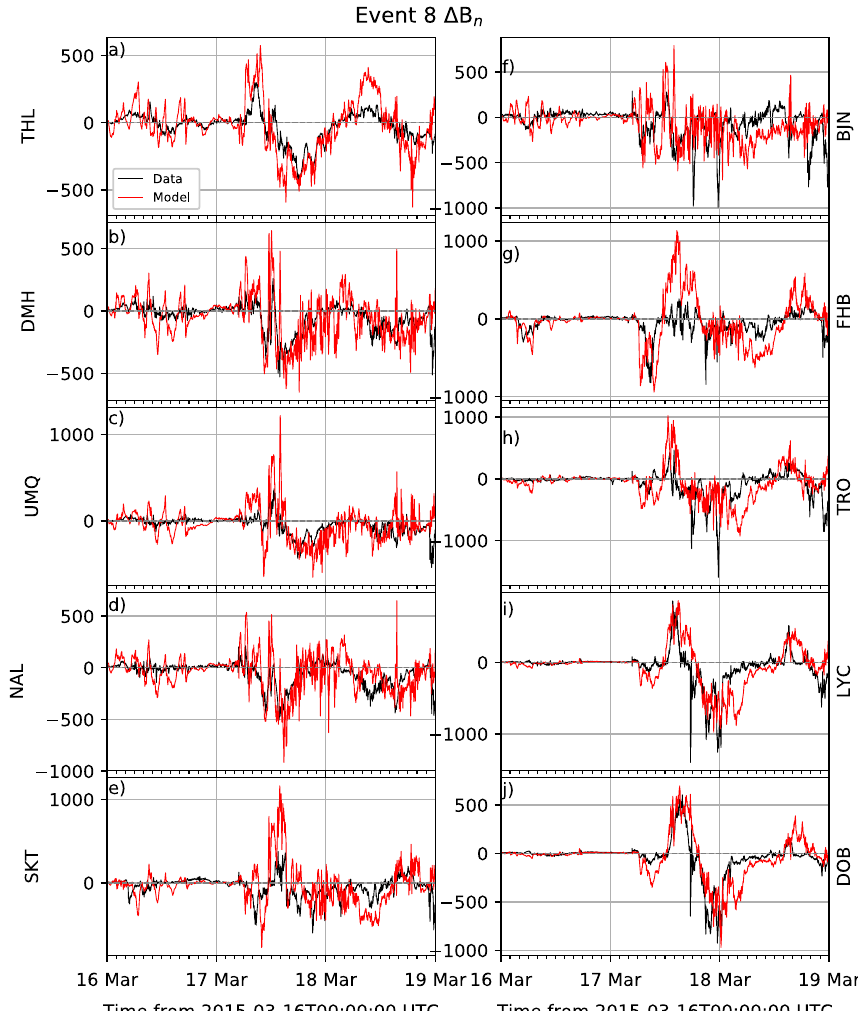
Fig. 3. Ground magnetic northward perturbations, D B n at all ground magnetometer stations for event 8. The black line shows the observed perturbations and the red line shows the modelled ground